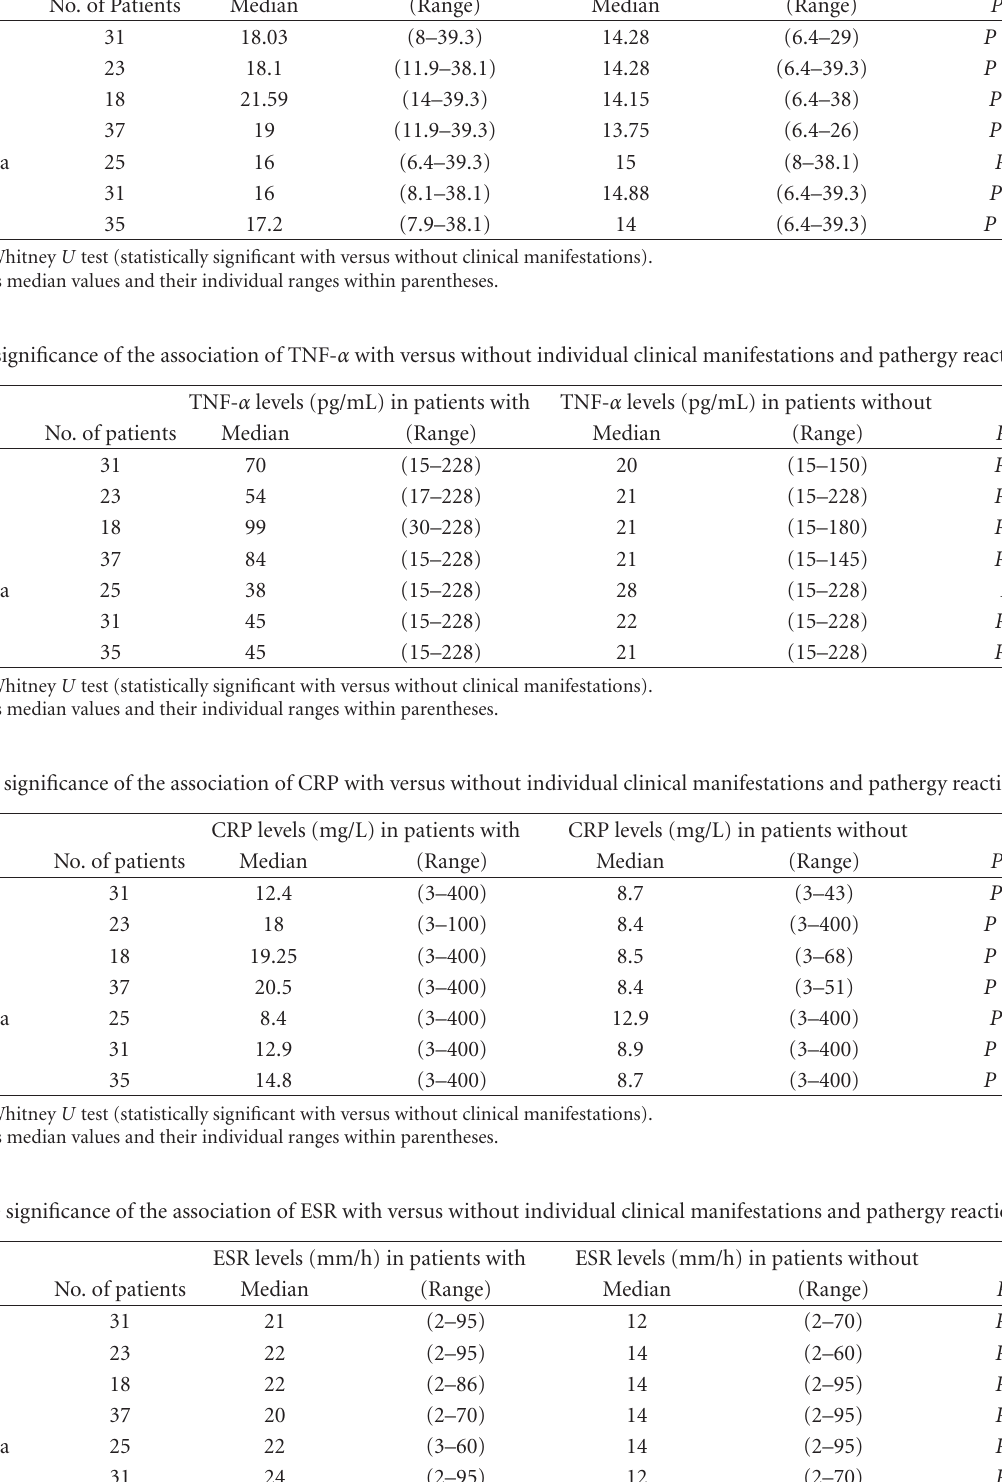
Table 3: The significance of the association of Hcy with versus without individual clinical manifestations and pathergy reaction. Hcy levels ( μ mol/L) in patients with